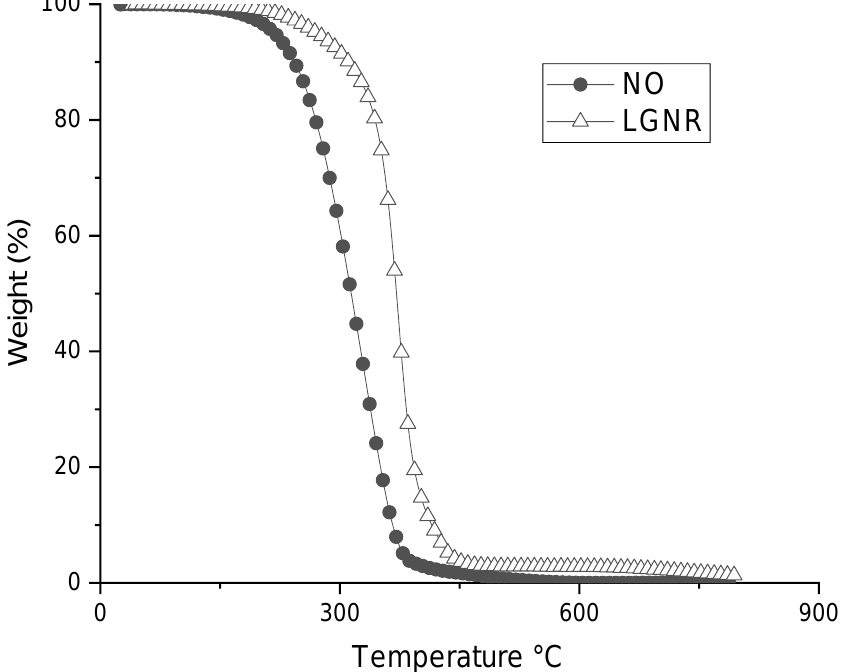
Figure 7. Weight–temperature curves of NO and LGNR. NO: naphthenic oil; LGNR: liquid guayule natural rubber.